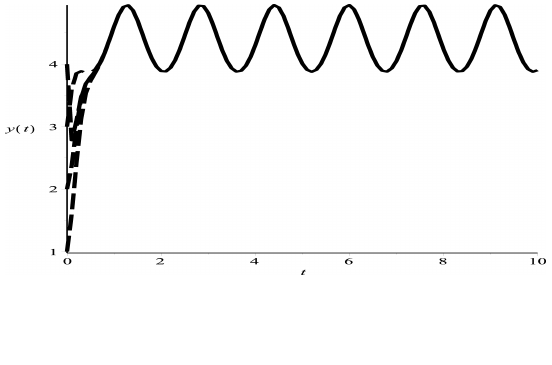
Fig. 6. Dynamic behavior of the second component y.t/ of the solution .x.t/;y.t// of system (64) with the initial conditions .x.0/;y.0// D .1;1/ , .2;2/ , .0:2;3/ and .7;4/ ,